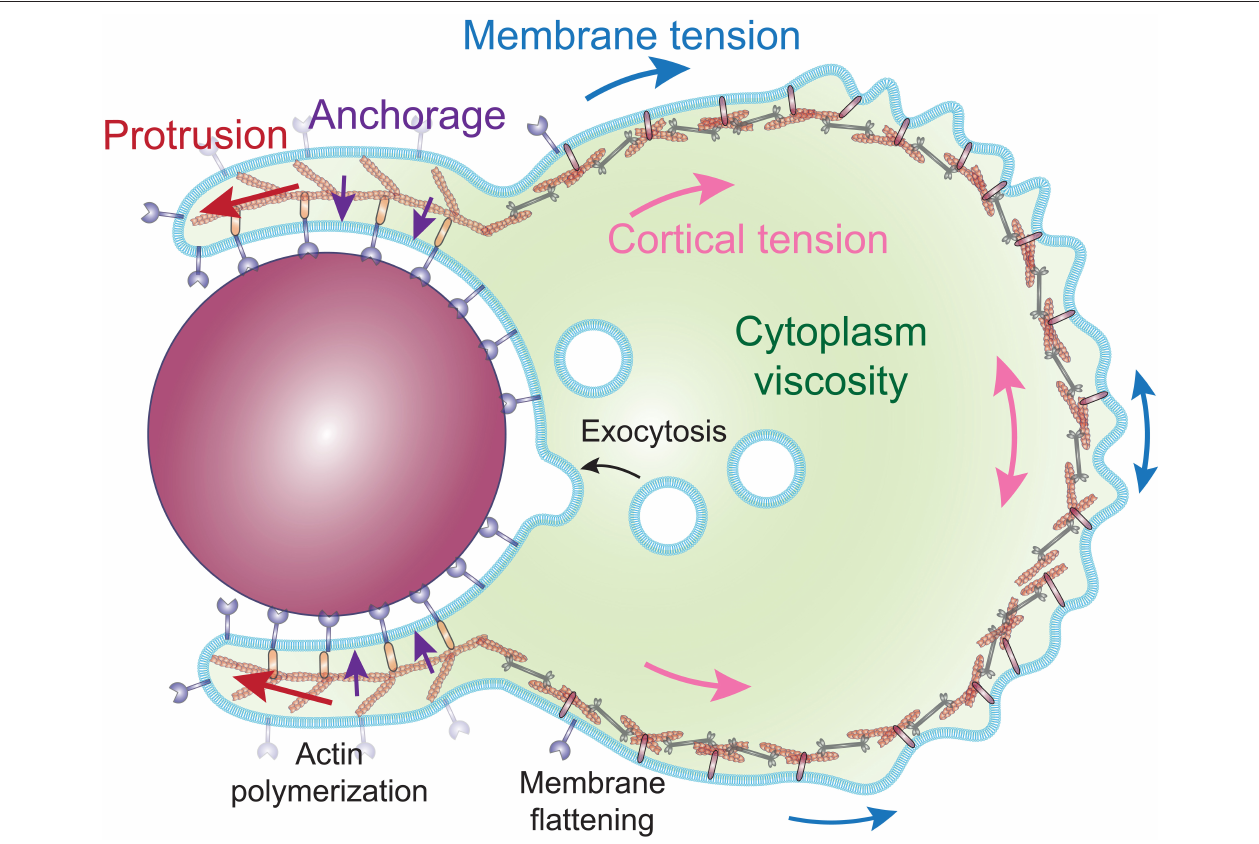
FIGURE 4 | Proposed model of the cellular forces involved during internalization by phagocytosis. Phagosome formation is driven by a protrusive force (red arrows), generated by the polymerization of actin filaments, directed along the particle by an attractive force (purple arrows), and coupling proteins that anchor the actin cytoskeleton to the cell-particle interface. The protrusive force works against the surface tension, composed of the cortical tension (pink arrows) and the membrane tension (blue arrows). The rate of deformation of the cell is determined by the ratio of the surface tension and the cytoplasm viscosity, while the surface tension effectively propels the particle inward. The in-line tension of the plasma membrane is compensated by the flattening of surface folds of the membrane and the exocytosis of intracellular